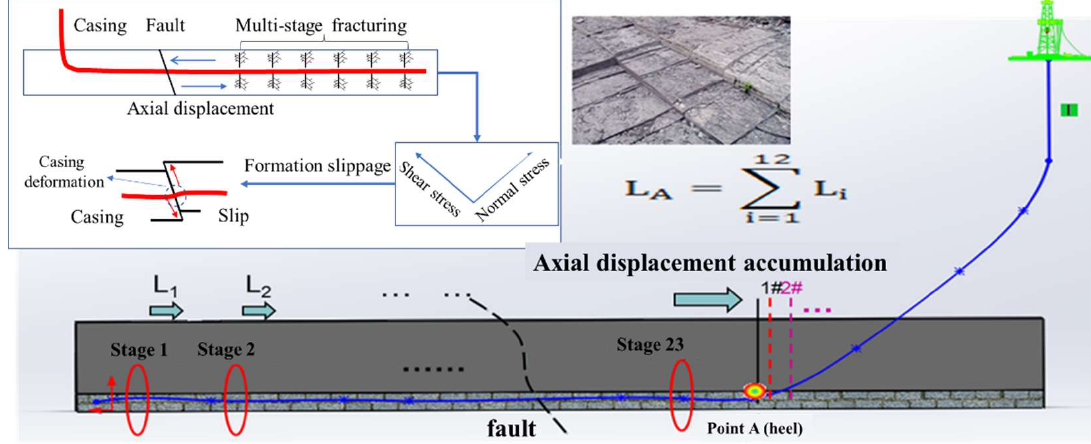
Figure 11. Schematic diagram of fault slip caused by a multi-stage fracturing operation.